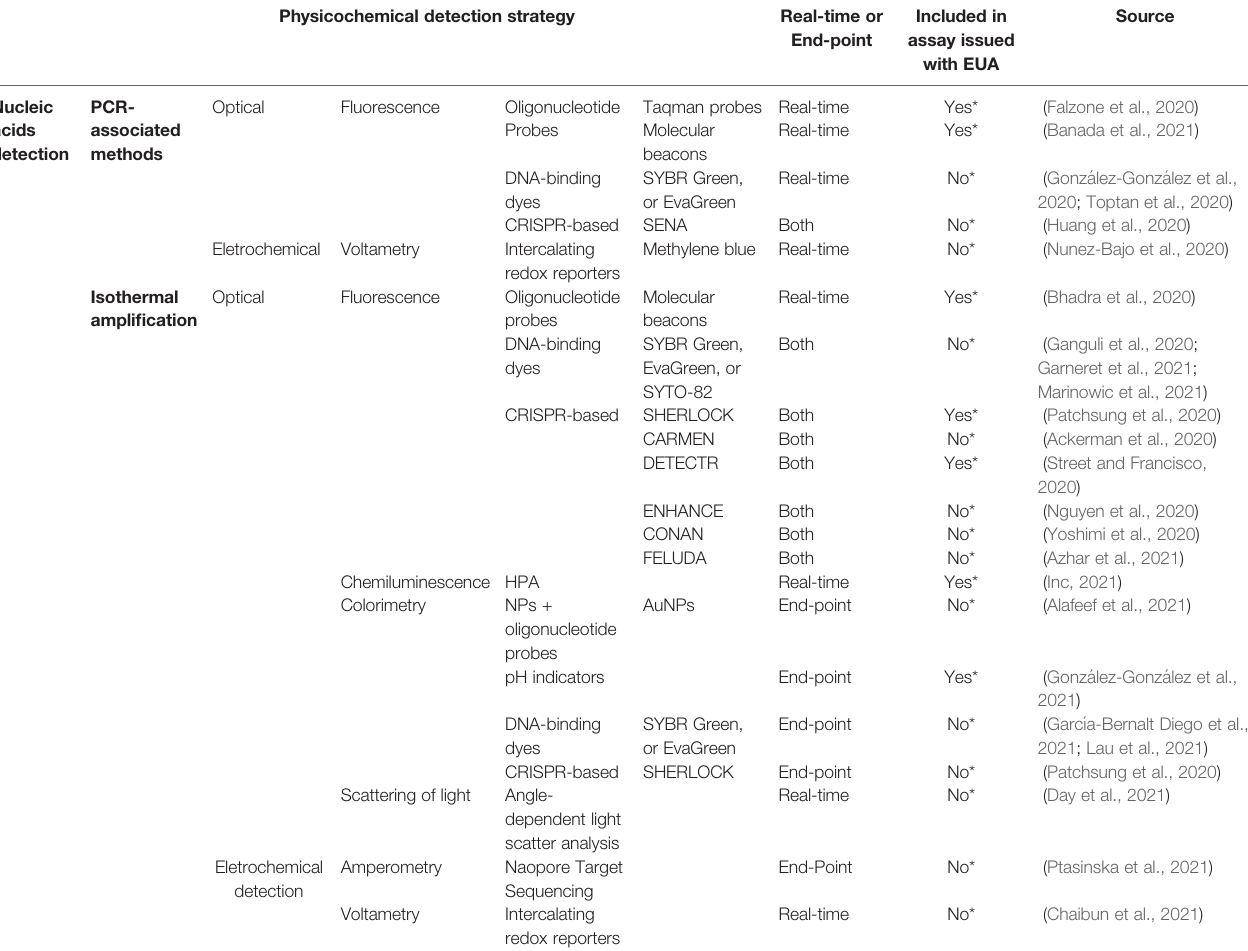
TABLE 6 | Depiction of distinct physicochemical routes used for performance of SARS-CoV-2